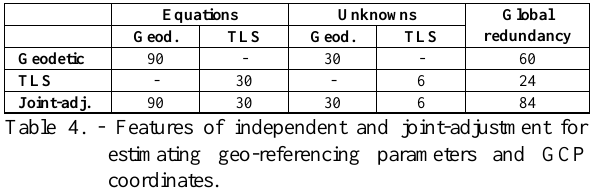
Table 4. - Features of independent and joint-adjustment for estimating geo-referencing parameters and GCP